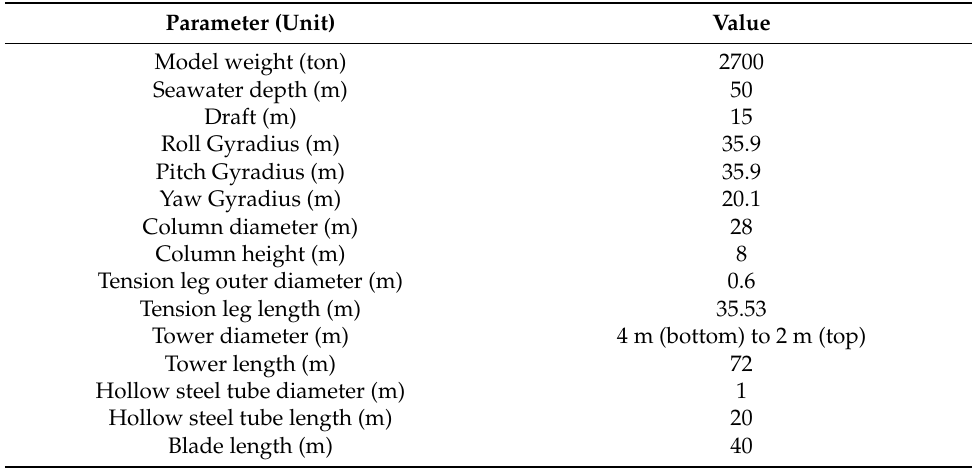
Figure 3. Numerical model of FOWT with four tension legs. Table 2. Main parameters of FOWT with inclined tension